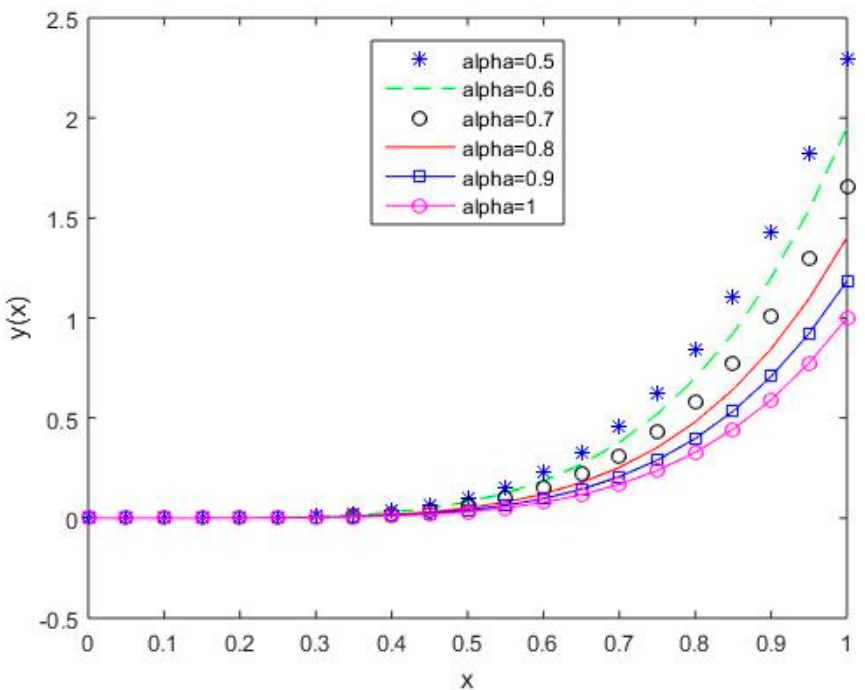
Figure 8. The behavior of solutions using S3 for α values of 0.5, 0.6, 0.7, 0.8, 0.9, and 1, Example 1.